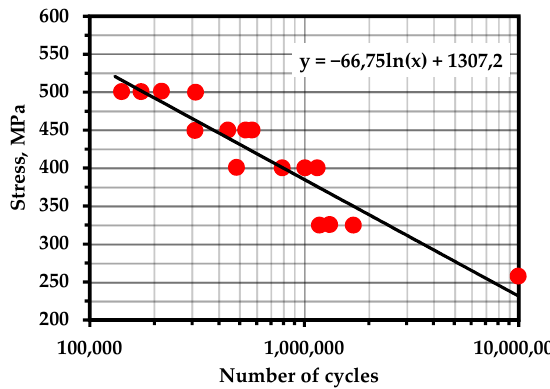
Figure A3. S–N Curve—Ti–6Al–4V (Temperature—298 K; frequency—110 Hz). Source—Base Material. Total